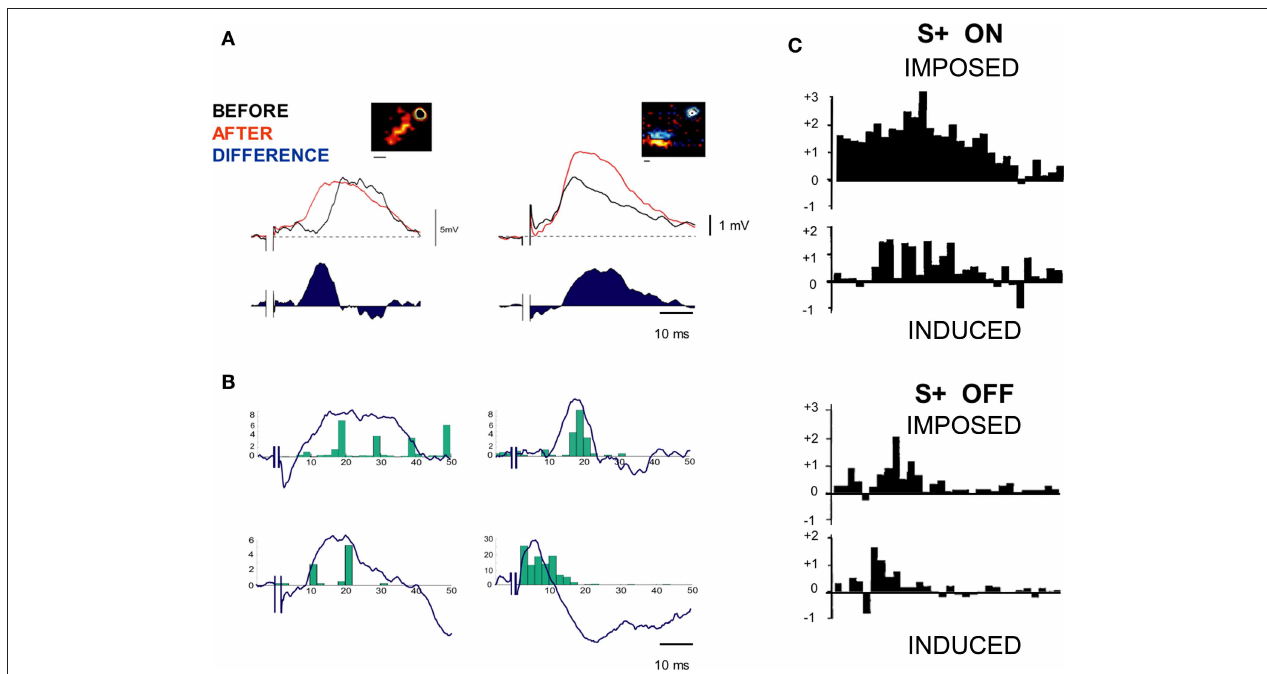
Figure 5 | Similarity between recalled and imposed postsynaptic patterns. (A) Examples of synaptic changes observed in the case of two cells. Insets represent the respective positions of cortical and thalamic RFs. The difference “AFTER–BEFORE” waveform (blue) shows the time course of the potentiation, corresponding to a shortening of latency (left) or an increase in peak amplitude (right). (B) Isomorphism between recalled and imposed postsynaptic patterns durin g TBS: The mean difference curves obtained for four different cells are superimposed with the mean spike pattern imposed during the conditioning bursts. This is done by realigning the trigger event of the control and post-TBS responses with the first thalamic shock in each high frequency burst applied during TBS. Note the similarities between the imposed spike distribution (green)